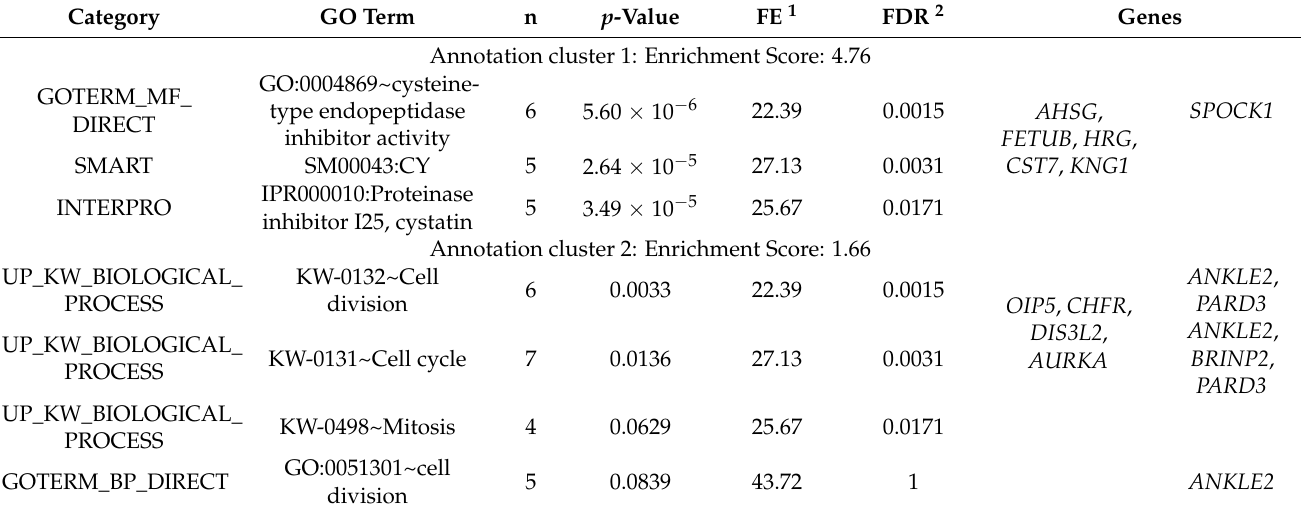
Table 4. Functional annotation and enrichment of gene ontology (GO) terms among the identified genes within the 0.4 Mb regions surrounding the identified